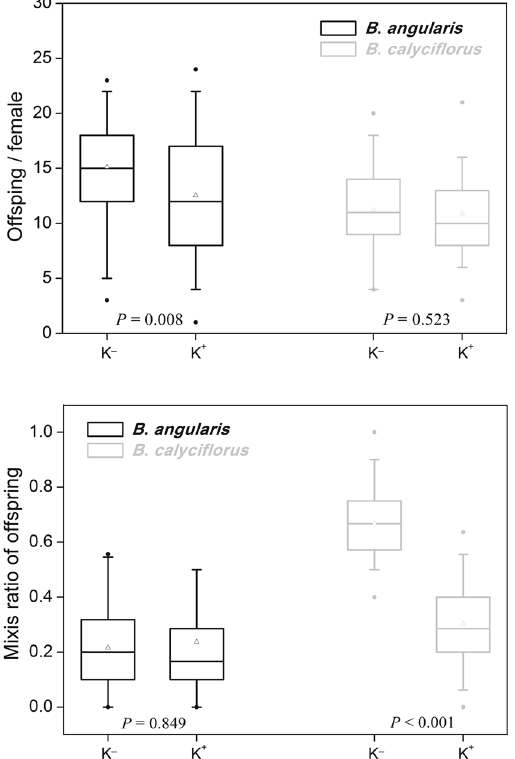
Figure 3. Boxplots of production and mixis ratio of offspring in Brachionus calyciflorus and Brachionus angularis cultured in the medium with (K + ) and without (K − ) Asplanchna kairomones. The solid horizontal line is the median and the triangle is the mean. The deviation bars represent the 5 th and 95 th percentiles, whereas the dots show the 1 th and 99 th percentiles. Data shown are based on 64 replicated Brachionus